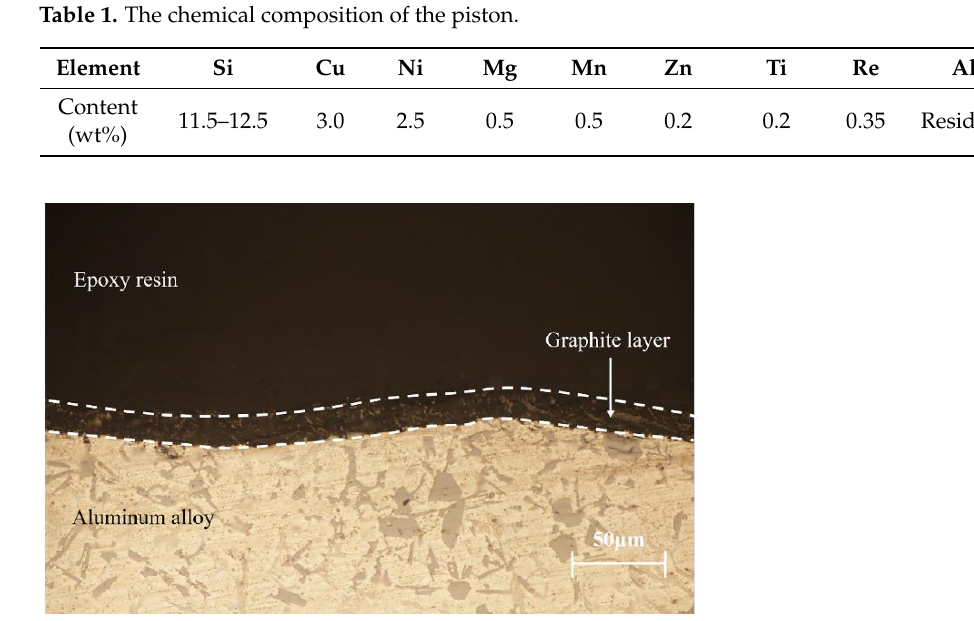
Figure 4. Metallographic analysis of the cross-section of the skirt.